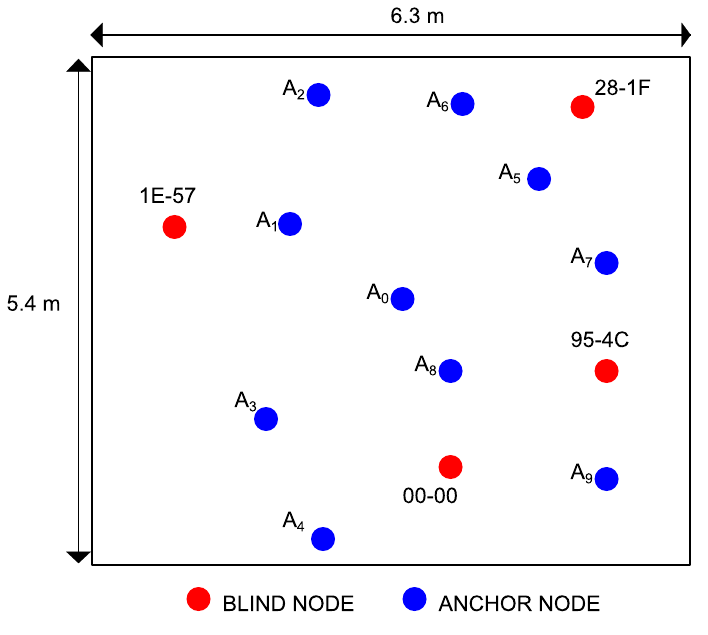
Figure 5. Position of the blind nodes and anchors for the conference room experiments.